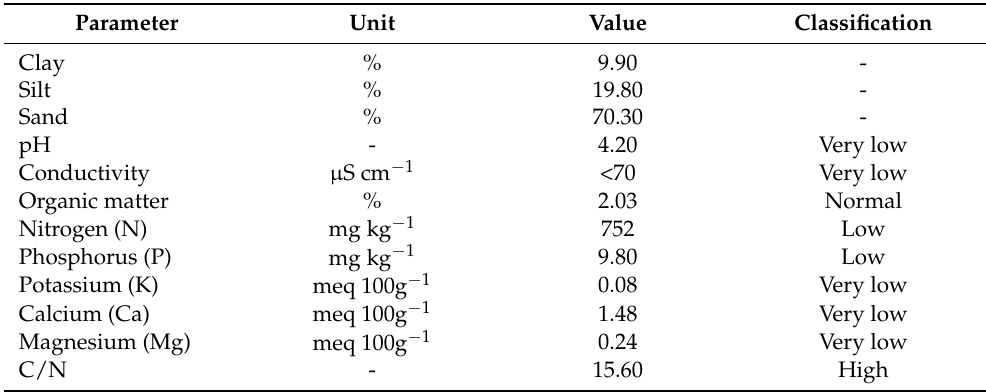
Table 3. Main soil